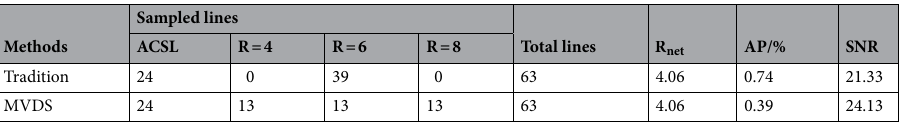
Table 3. The comparison of reconstruction images sampled using traditional methods and MVDS method.